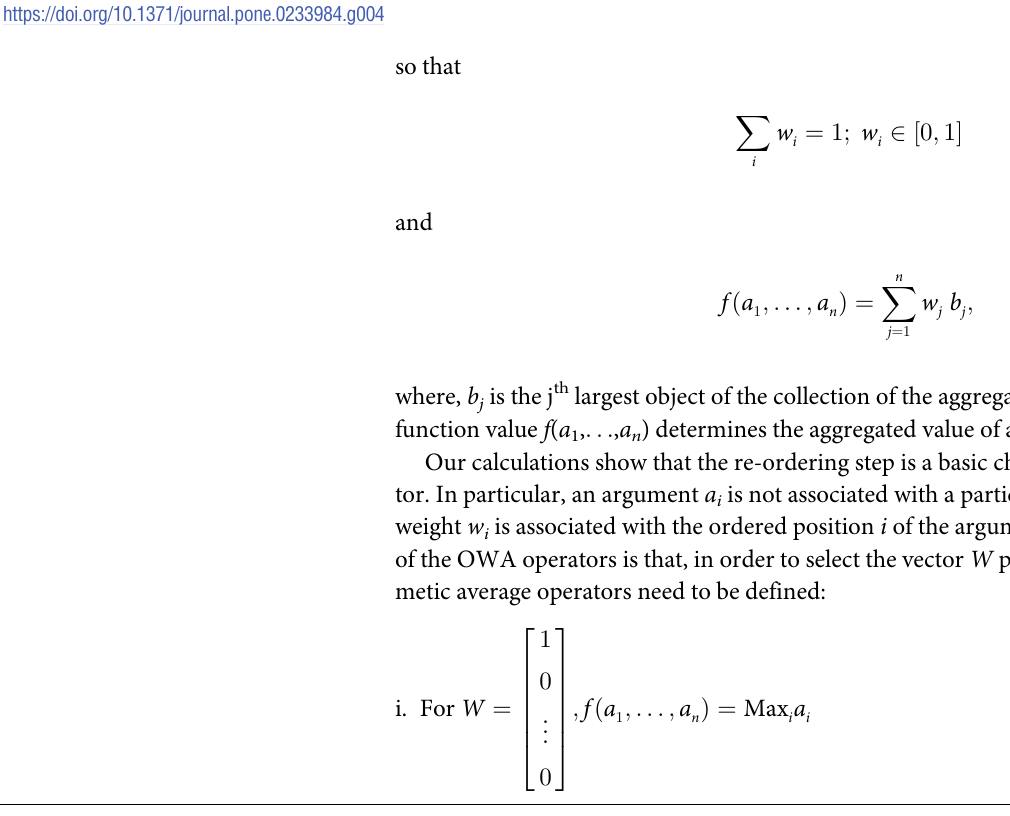
Fig 4. The steps of the aggregation